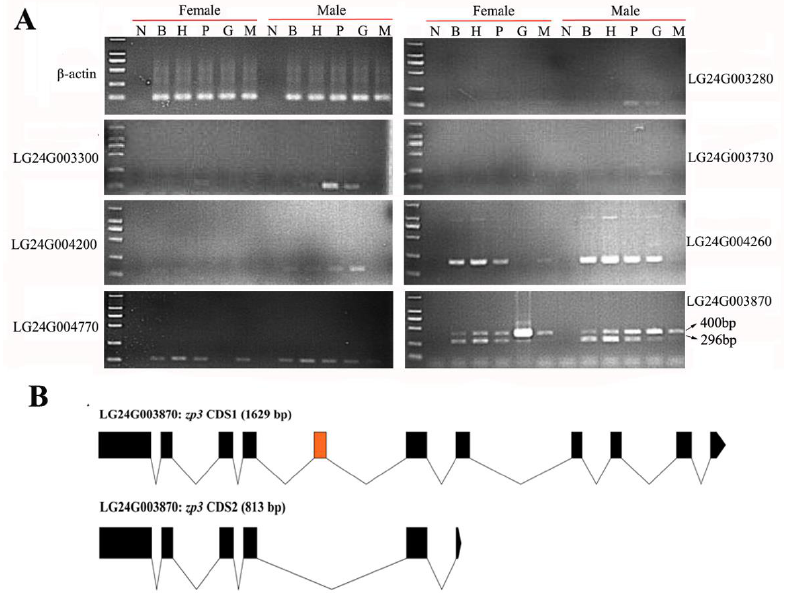
Figure 3. Routine PCR detection of gonadal differentially expressed genes in the HPG axis and muscle tissue and the structural difference of transcripts in one gene. ( A ) The expression of gonadal differentially expressed genes in the HPG axis and muscle tissue was detected by routine PCR. B, H, P, G, and M denote the brain, hypothalamus, pituitary, gonads, and muscle, respectively; N represents the negative control. ( B ) Schematic diagram of the genomic structure of two transcripts of LG24G003870 gene in the CDS region. The orange box indicates the missing exon in CDS2 that causes premature termination of translation.